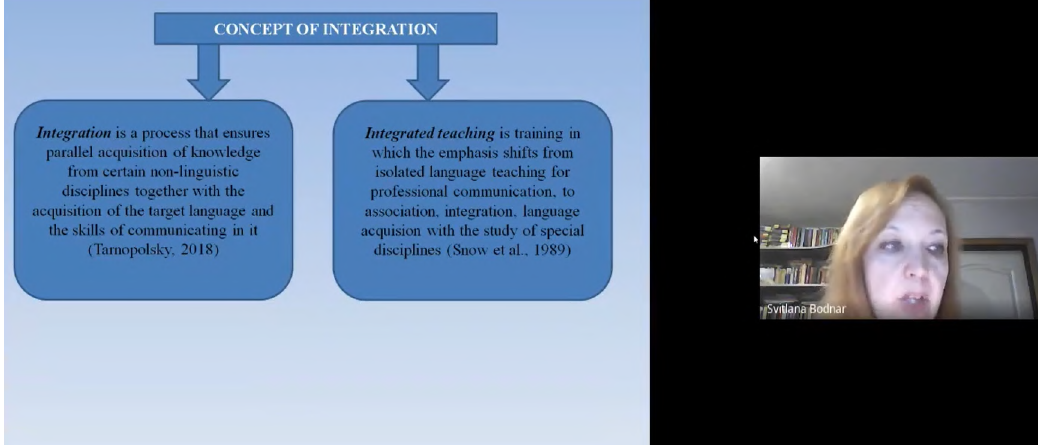
Figure 67: Presentation of paper